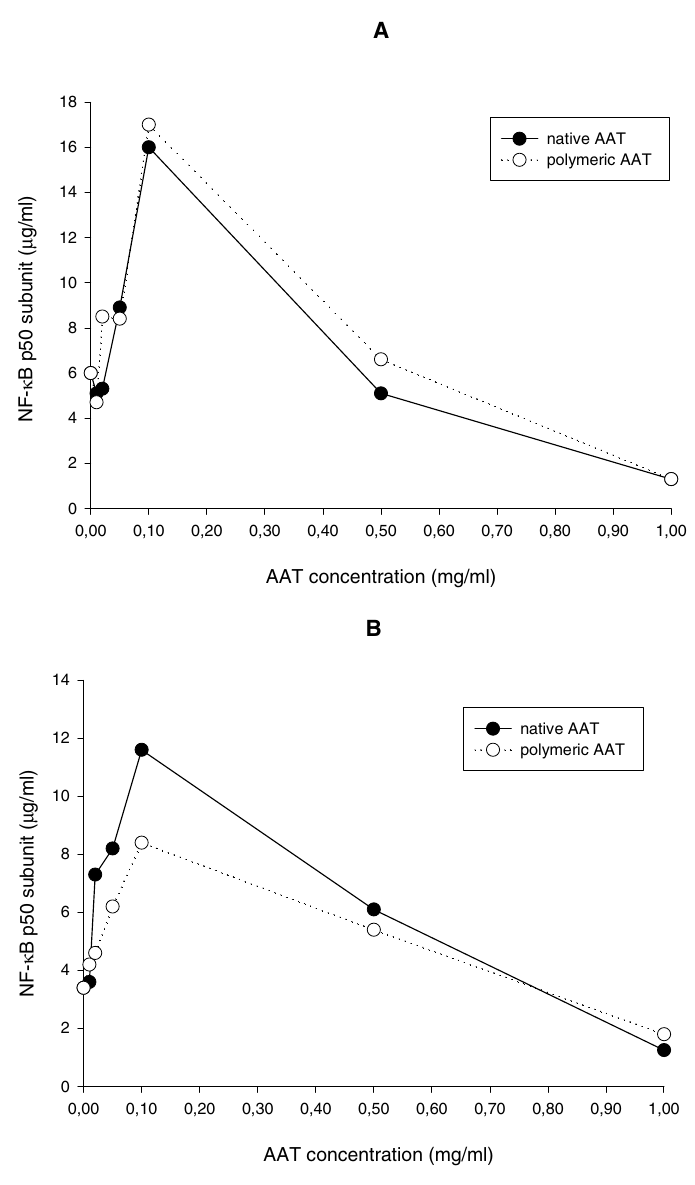
Figure 4 A and B. Monitoring of NF κ B p50 activation in monocytes after 18 h of exposure to different concentrations of native or polymerized AAT by ELISA-based TransAM kit AM . Cell nuclear extracts were prepared from monocytes alone or treated with different concentrations of AAT. NF κ B activity assay was performed in 96-well plates with 10 µ g of cell extract per well. Absorbance was measured by spectrophotometry at 450 nm. Specificity controls were performed by adding a molar excess (20 pmol/well) of mutant NF κ B oligonucleotide (the positive signal remained unaffected) and wild-type NF κ B oligonucleotide (a signal was abolished). A and B represent results from two independent experiments. Each point represents the mean of two